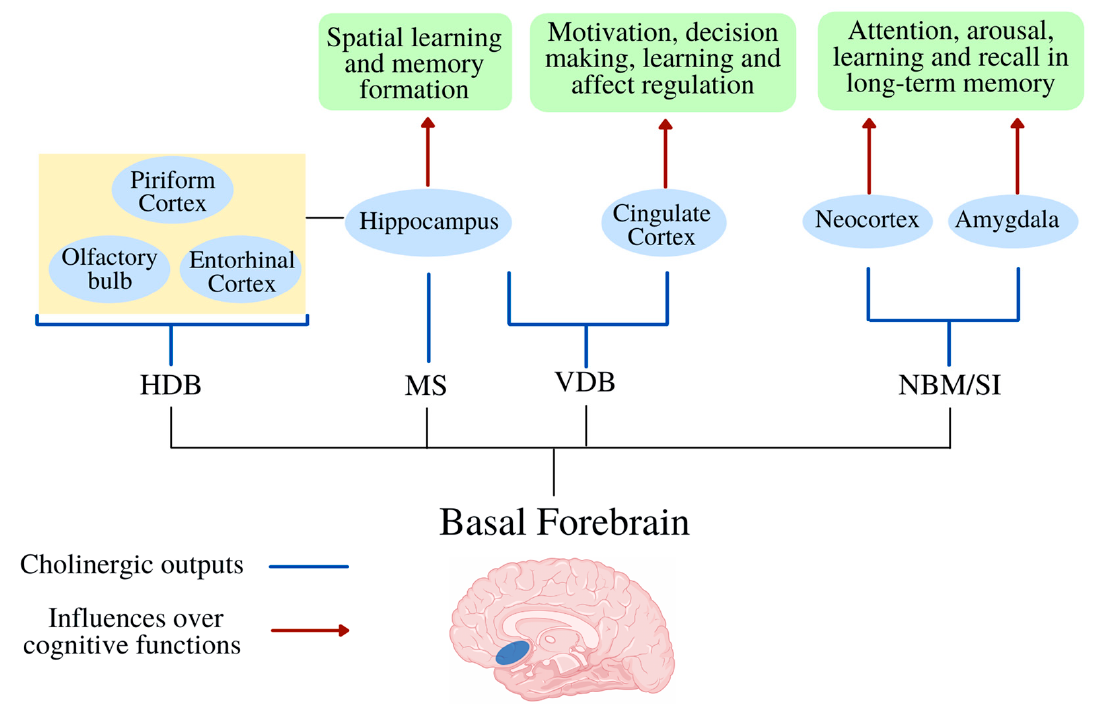
Figure 3. Cholinergic outputs of the Basal Forebrain. The Basal forebrain (BF) is composed of the medial septum (MS), vertical limb of the diagonal band of Broca (VDB), horizontal limb of the diagonal band of Broca (HDB), and nucleus basalis magnocellularis (NBM), or substantia innominata (SI); the Basal forebrain has many cholinergic outputs with several cortical and subcortical structures; all of which have some influence over important cognitive